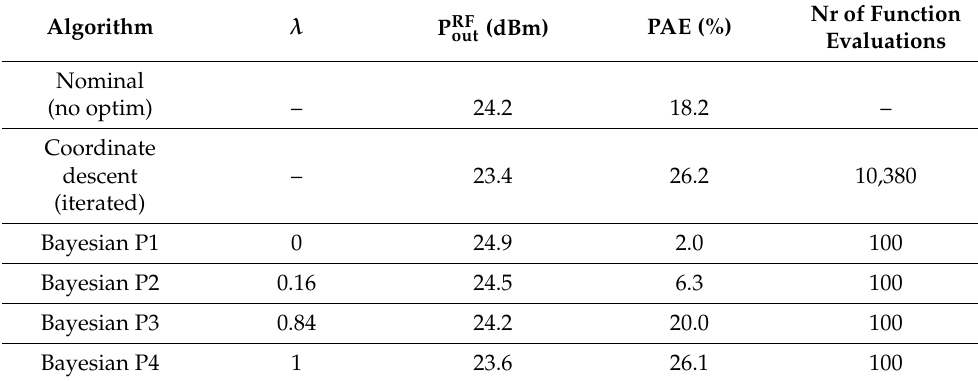
Table 5. Comparison of PA performances obtained by means of PDF-based SUMO simulation at the optimal